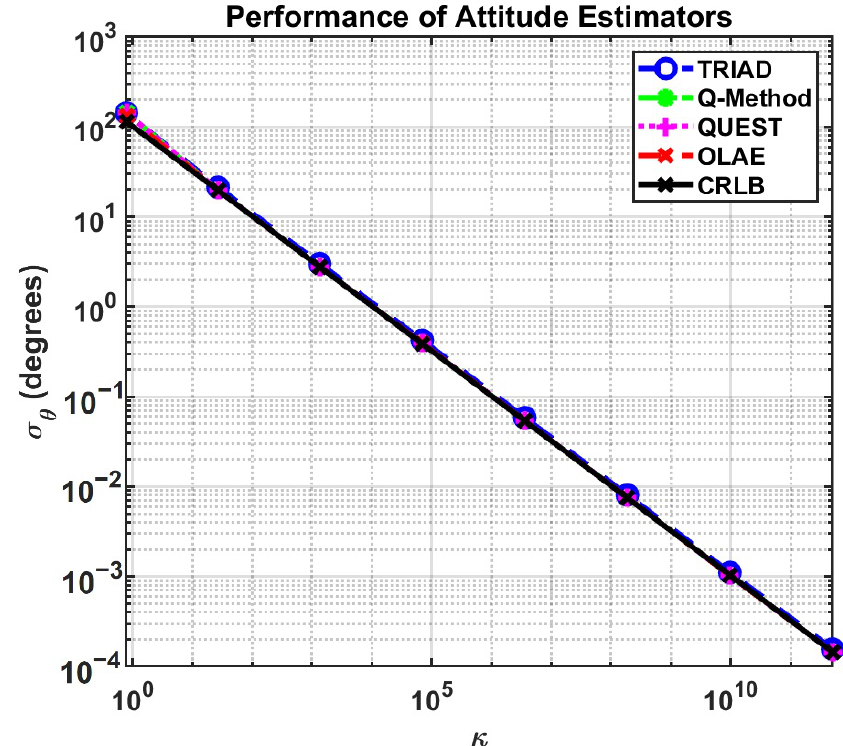
Figure 9. The 3D orientation CRLB vs. concentration for several attitude